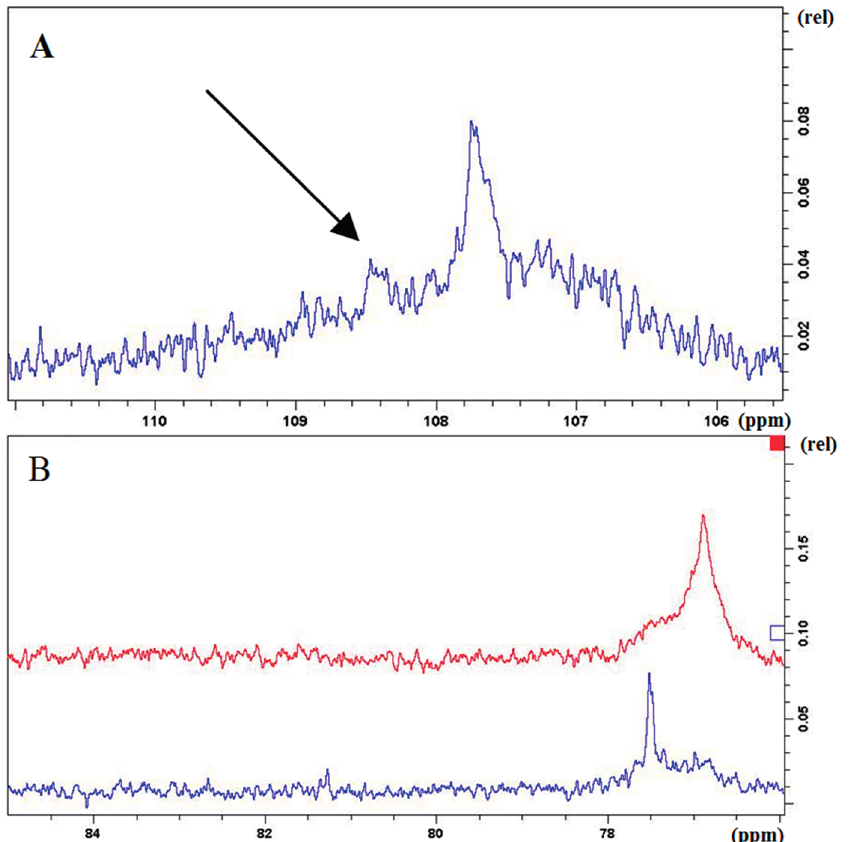
Figure 3. A : Signal at 108.4 ppm in the 13 C-spectrum of the “regular” PAs indicating the presence of monomeric flavan-3-ols with trihydroxylated B-rings; B : 76–85 ppm of the 13 C-NMR spectra of the “regular” ( upper ) and “unusual” ( lower ) PAs. The area of 76–78 ppm is representative for the C-2 of 2,3 -cis configurated flavan-3-ol units. The signals of 2,3 -trans configurated units would appear in between 82 and 84